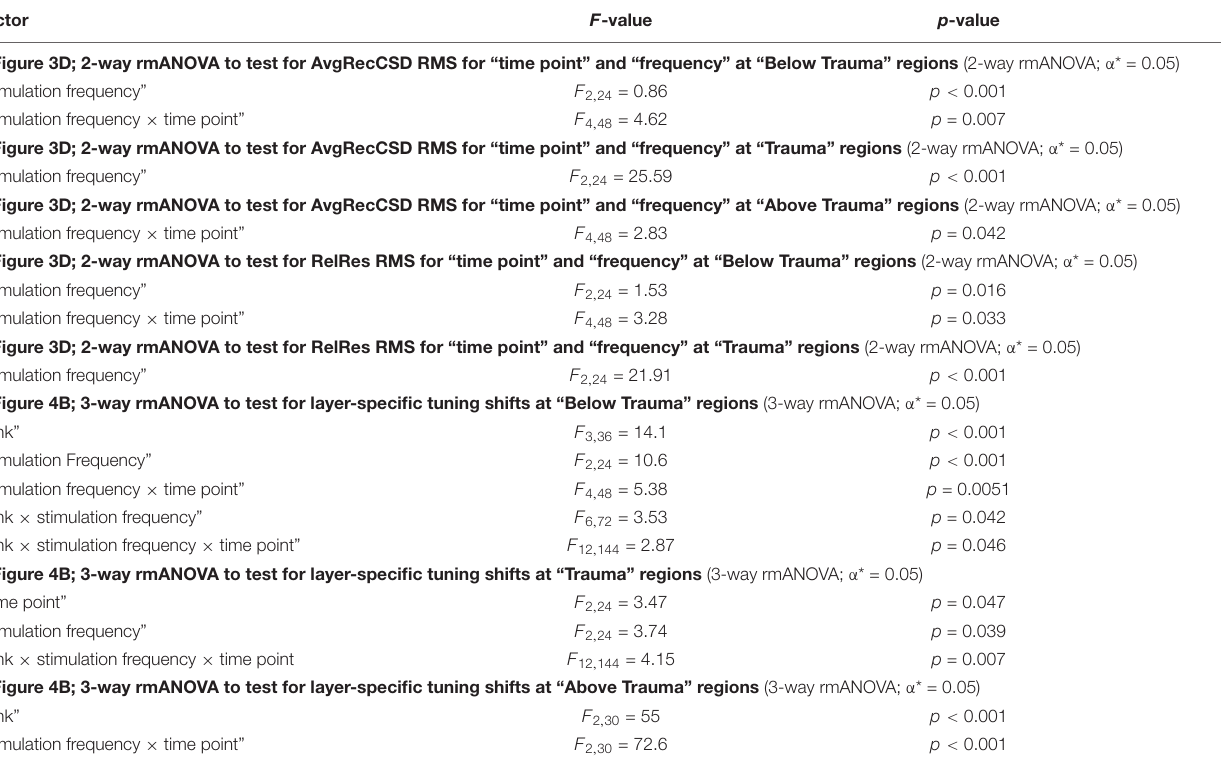
Factor F -value 1. Figure 3D; 2-way rmANOVA to test for AvgRecCSD RMS for “time point” and “frequency” at “Below Trauma” regions (2-way rmANOVA; α * = 0.05)